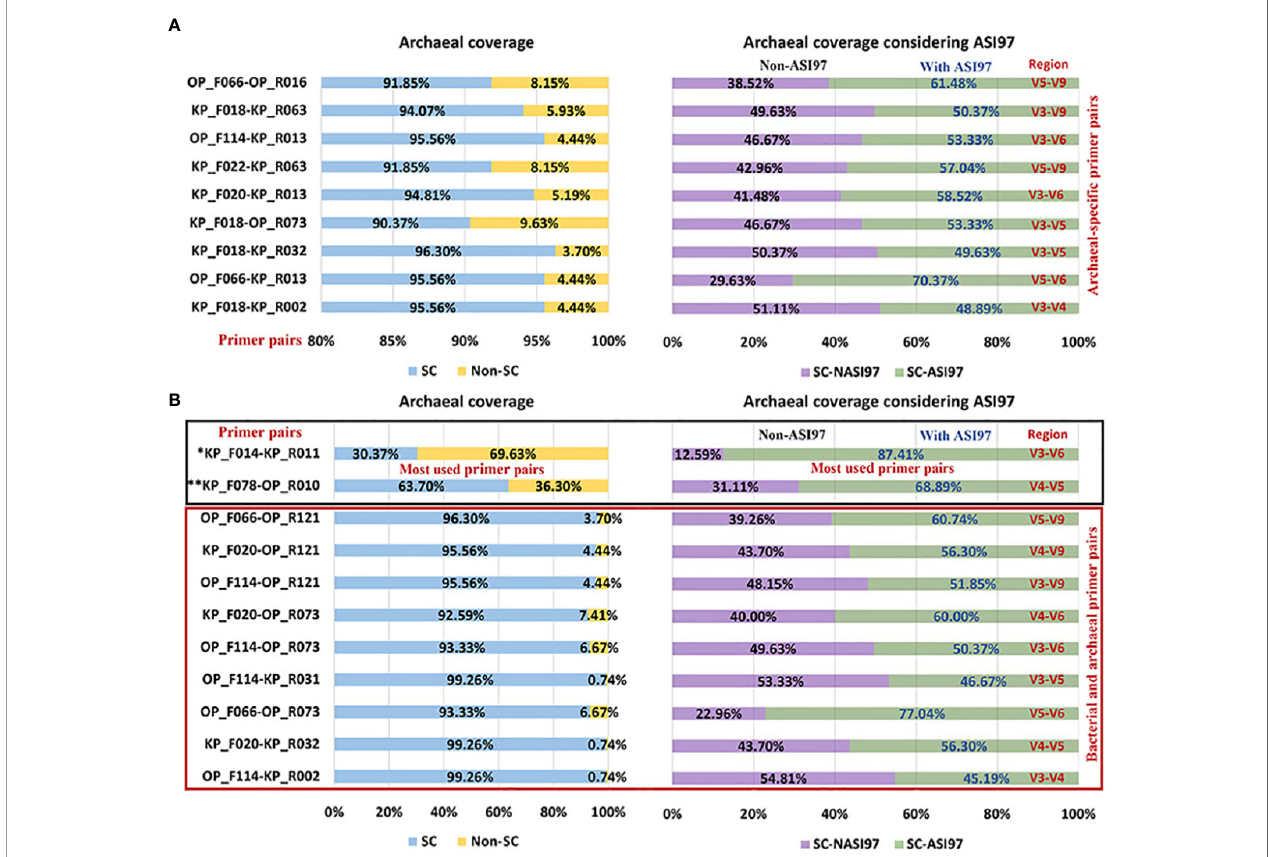
FIGURE 5 | Percentages of coverage and coverage considering the species with in-silico amplicon similarity values ≥ 97% of the primer pairs evaluated against the oral archaea genomes. (A) Percentages obtained by the selected archaeal-speci fi c primer pairs. (B) Percentages obtained by the selected bacterial and archaeal primer pairs and the primer pairs used the most in the oral-microbiome literature. Among the most commonly used primer pairs in the literature, those marked with an * are archaeal-speci fi c and those with ** target both bacterial and archaea. ASI97, in-silico amplicon similarity values ≥ 97%; F, forward; KP, Klindworth primer; Non-SC, non-coverage of species; OP, oral primer; R, reverse; SC, species coverage; SC-ASI97, species coverage with in-silico amplicon similarity values ≥ 97%; SC-NASI97, species coverage with no in-silico amplicon similarity values ≥